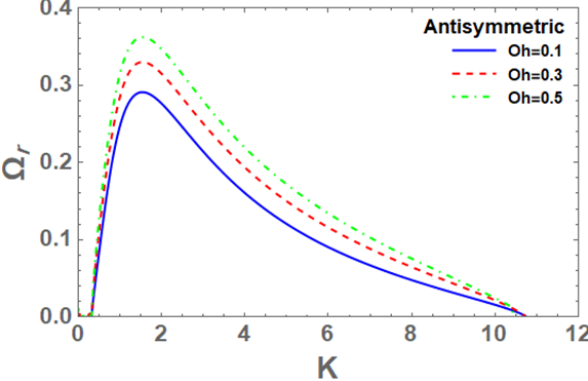
Figure 4. Non-dimensional growth rate Ω r and non-dimensional wave number K for differ- ent values of Ohnesorge number Oh , when We = 1000; N = 1; ρ = 0.01; v = 0.2; κ 1 = 2; ˜ (cid:101) l = 0.3; ˜ (cid:101) g = 0.1; E = 3; U = 1.5; V (cid:48) = 0.1; ε = 0.5, for axisymmetric disturbance